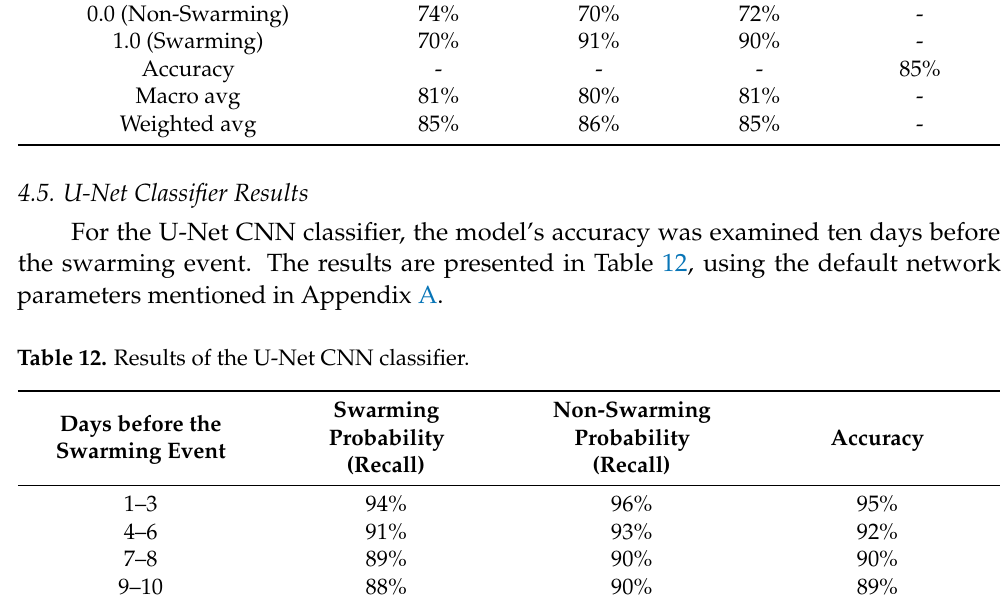
Table 11. k-NN Classifier results applied ten days before the swarming event. Precision Recall F1-Score